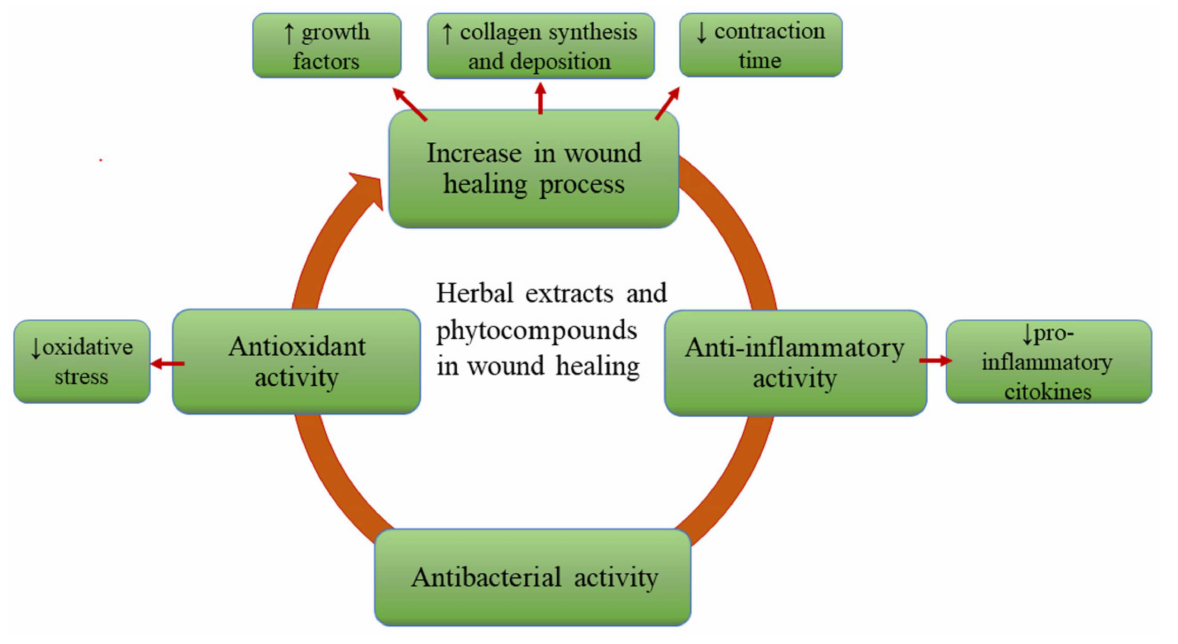
Figure 2. The main beneficial effects of herbal extracts and phytocompounds in wound